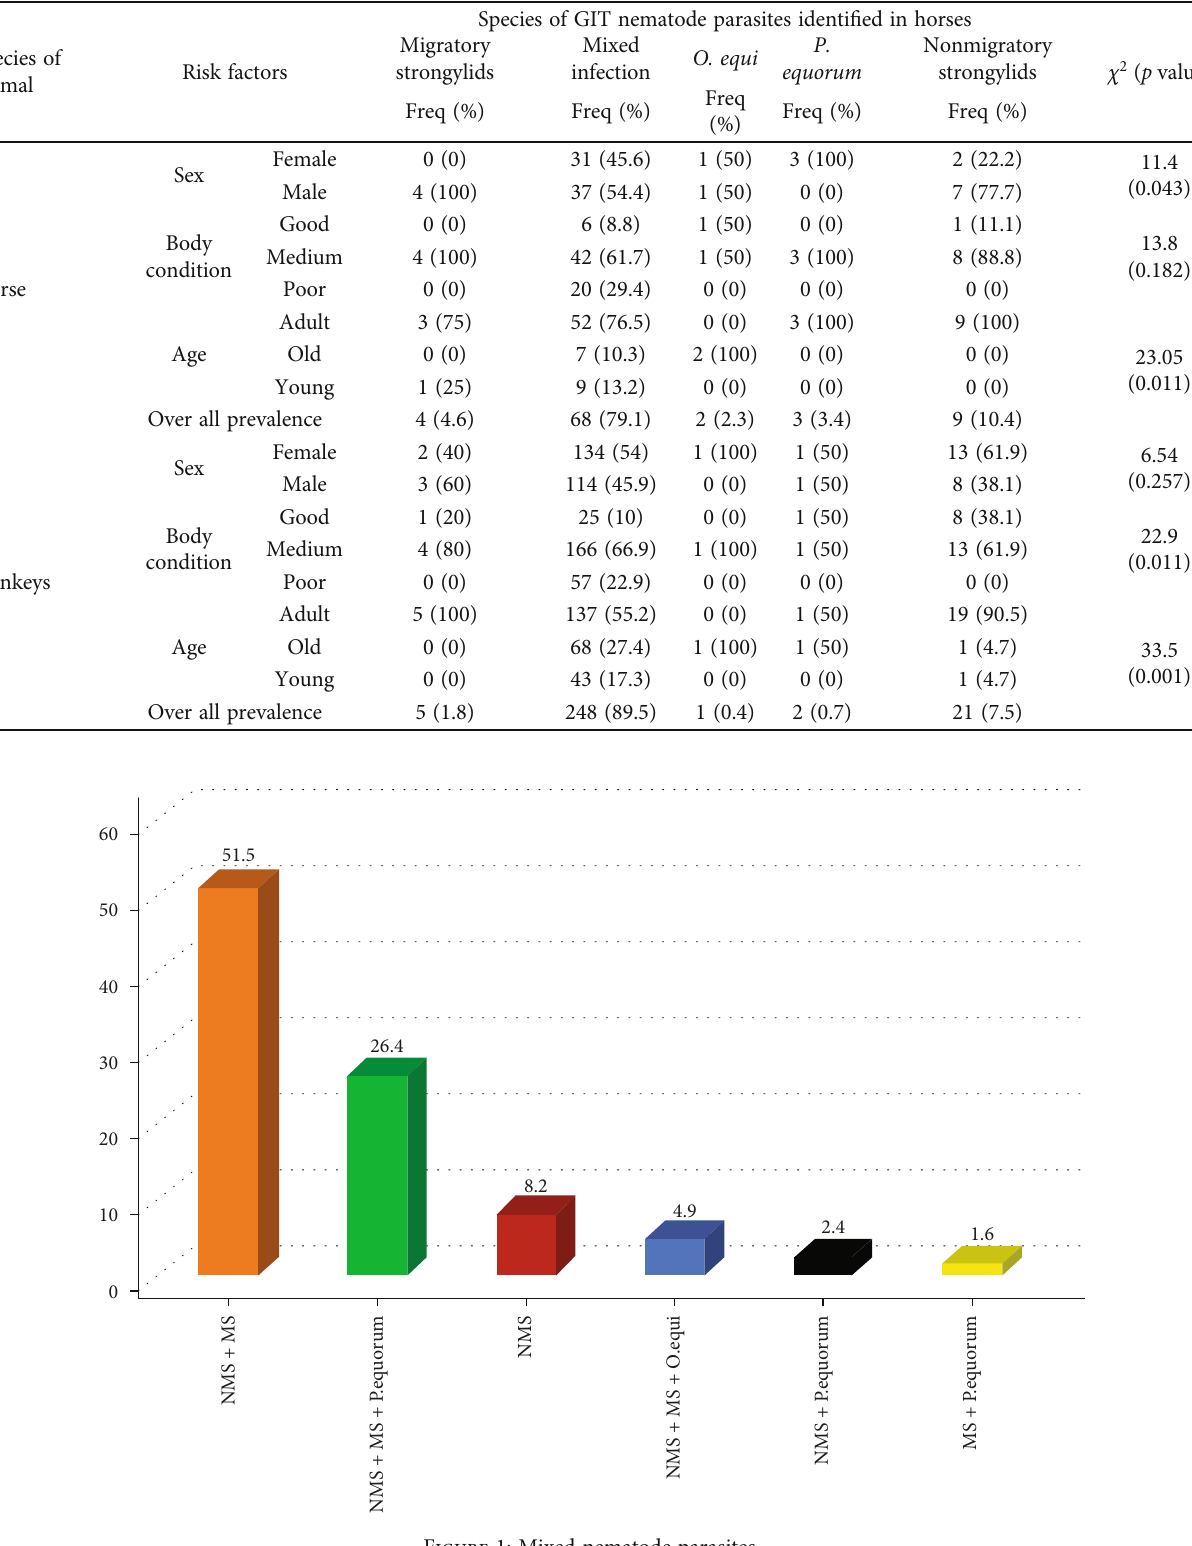
Figure 1: Mixed nematode